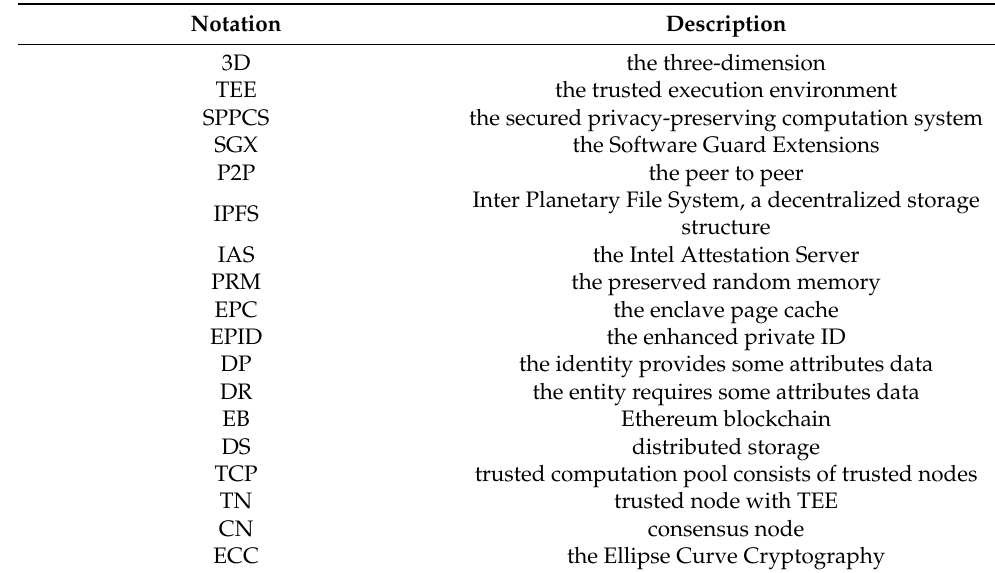
Figure 2. The architecture of SPPCS. Table 1.